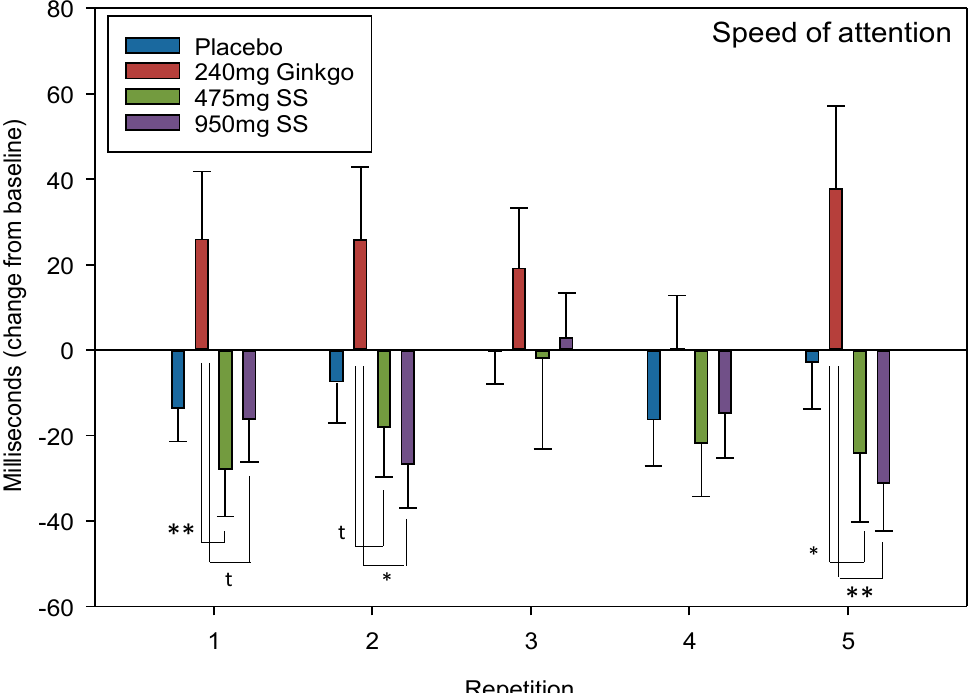
Repetition1 2 3 4 5